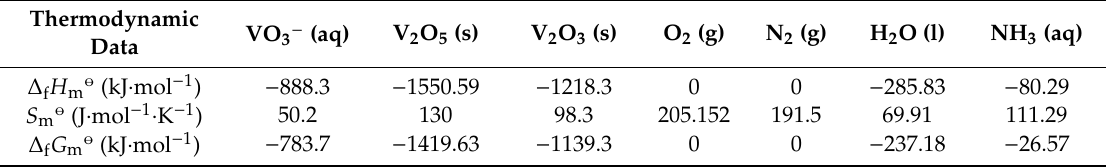
Table 7. Thermodynamic data.